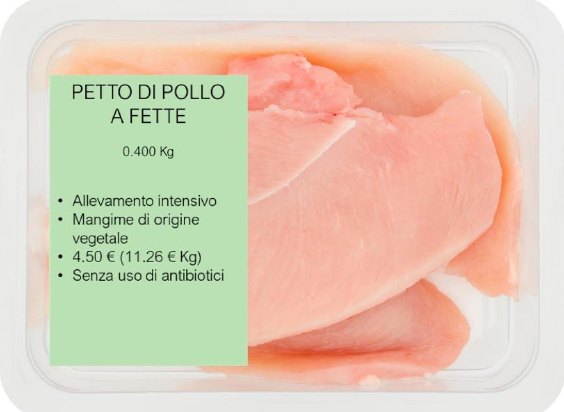
Figure 1. One of the product’s profiles presented to participants.